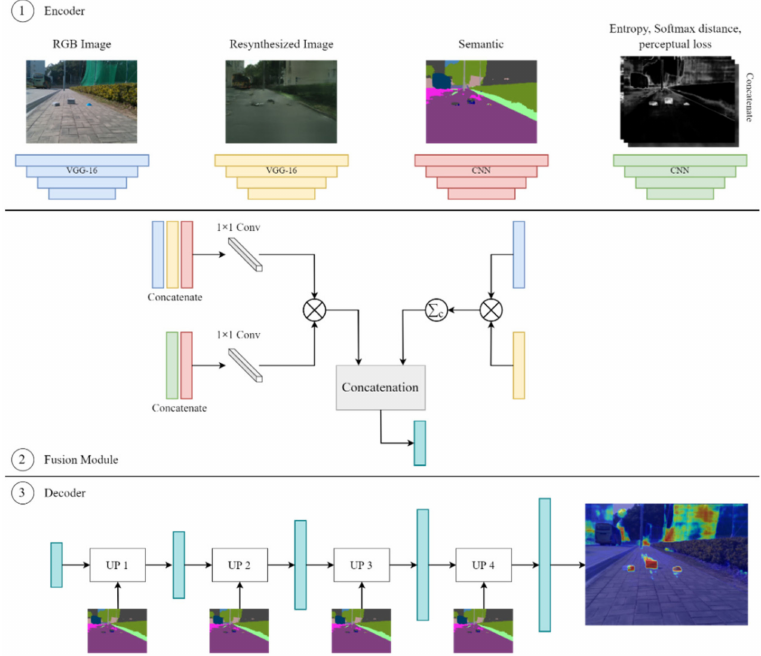
Figure 3. The schematic of DissimNet module aims to generate the anomaly